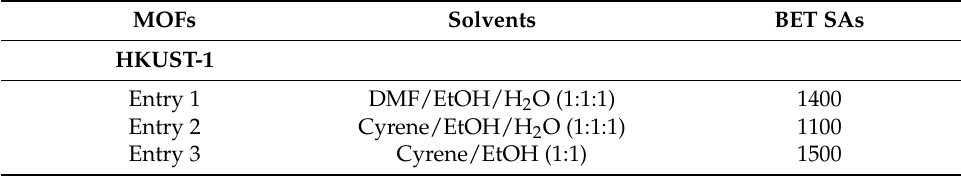
Table 3. BET surface area of HKUST-1 with different solvents.